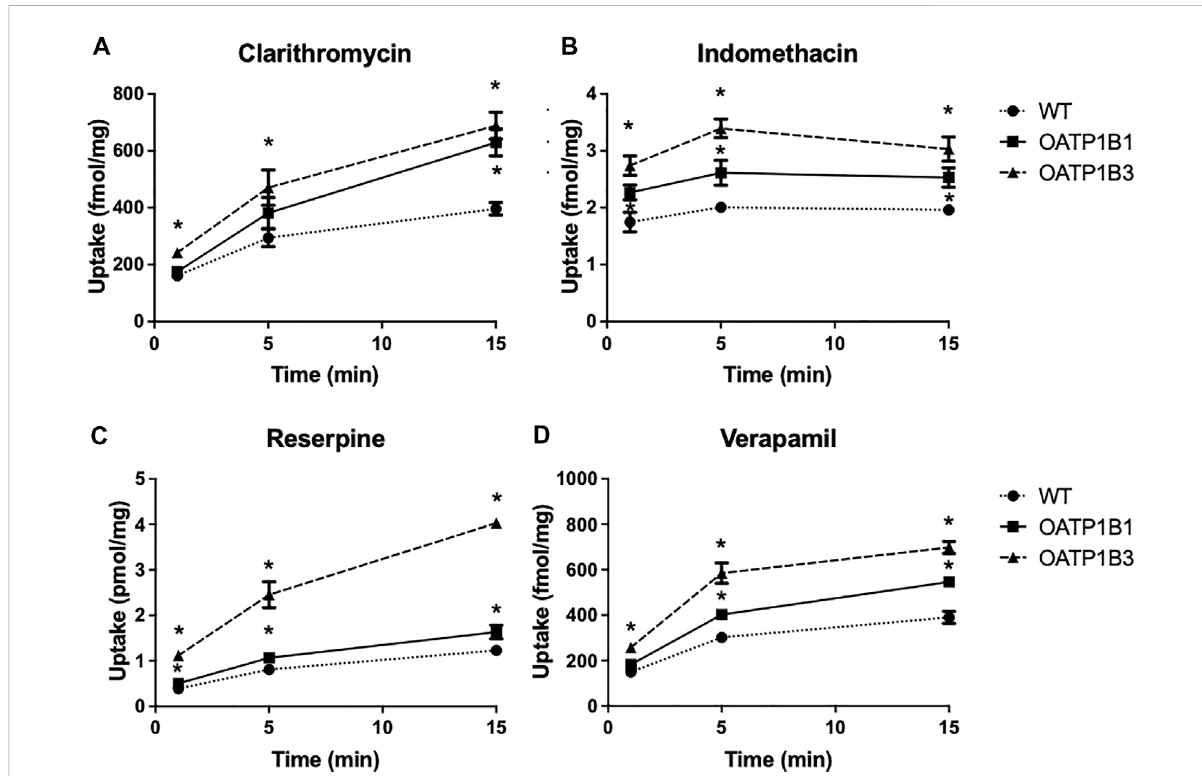
FIGURE 3 Time-dependent uptake of compounds predicted to be OATP substrates based on the CCF assay. Uptake of [ 3 H]-clarithromycin (12.3 nM) (A) , [ 3 H]-indomethacin(30 nM) (B) ,[ 3 H]-reserpine(15 nM) (C) ,and[ 3 H]-verapamil(1.8 nM) (D) wasmeasuredusingCHOcellsstablyexpressingOATP1B1 (squares), OATP1B3 (triangles), and wildtype CHO cells (circles) at 37 ° C on 24-well plates, and corrected for total protein. Two to three experiments were performed. The values (means ± SD) shown are from one representative